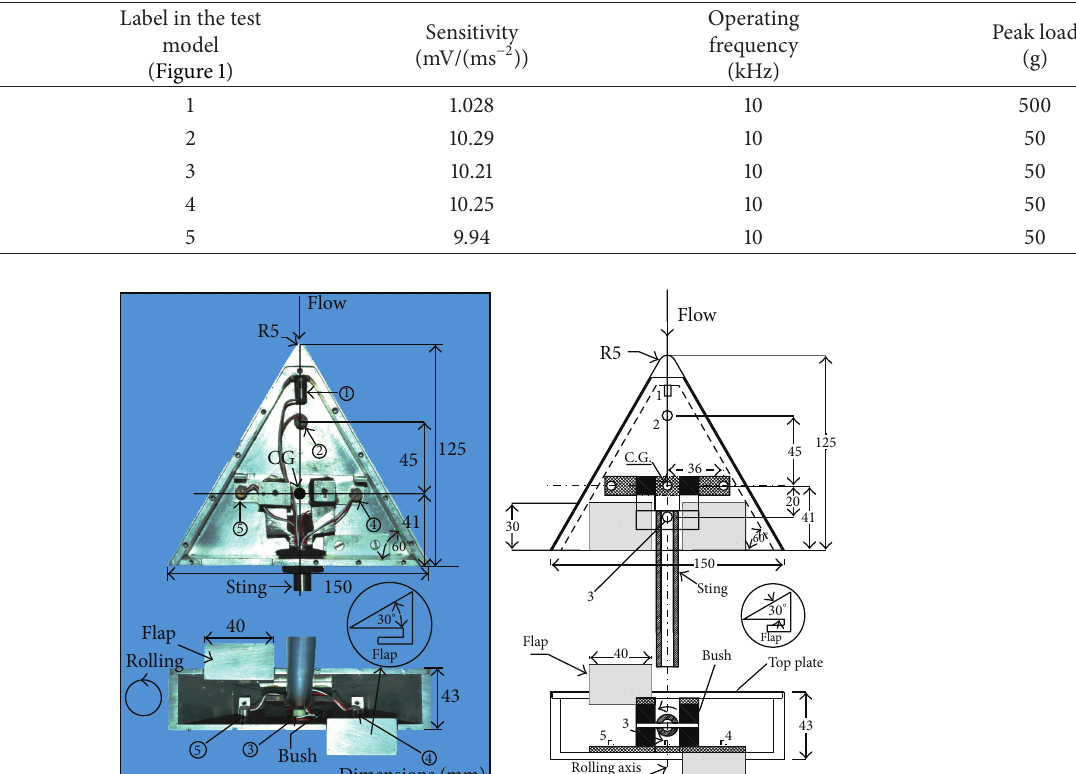
Table 2: Properties of accelerometers.